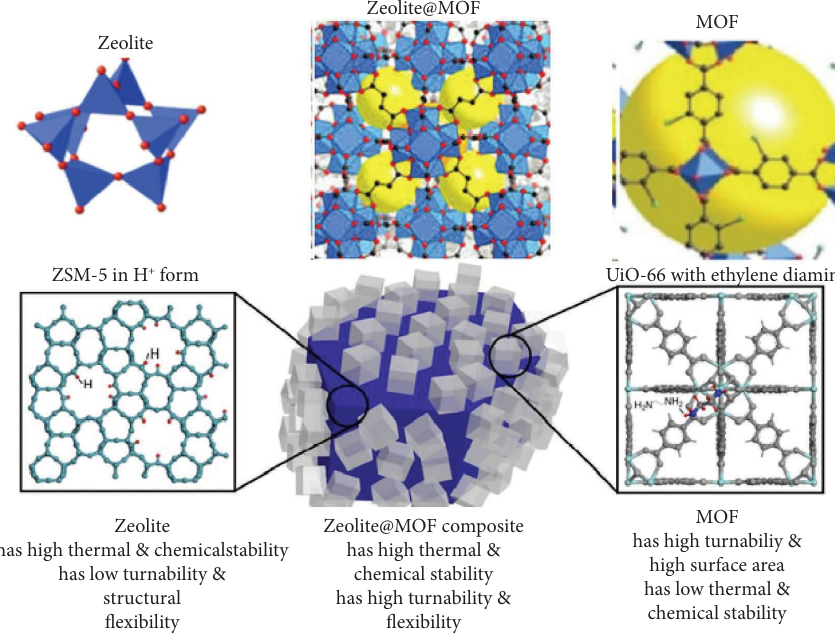
Figure 5: Zeolite@MOF composite modifed from